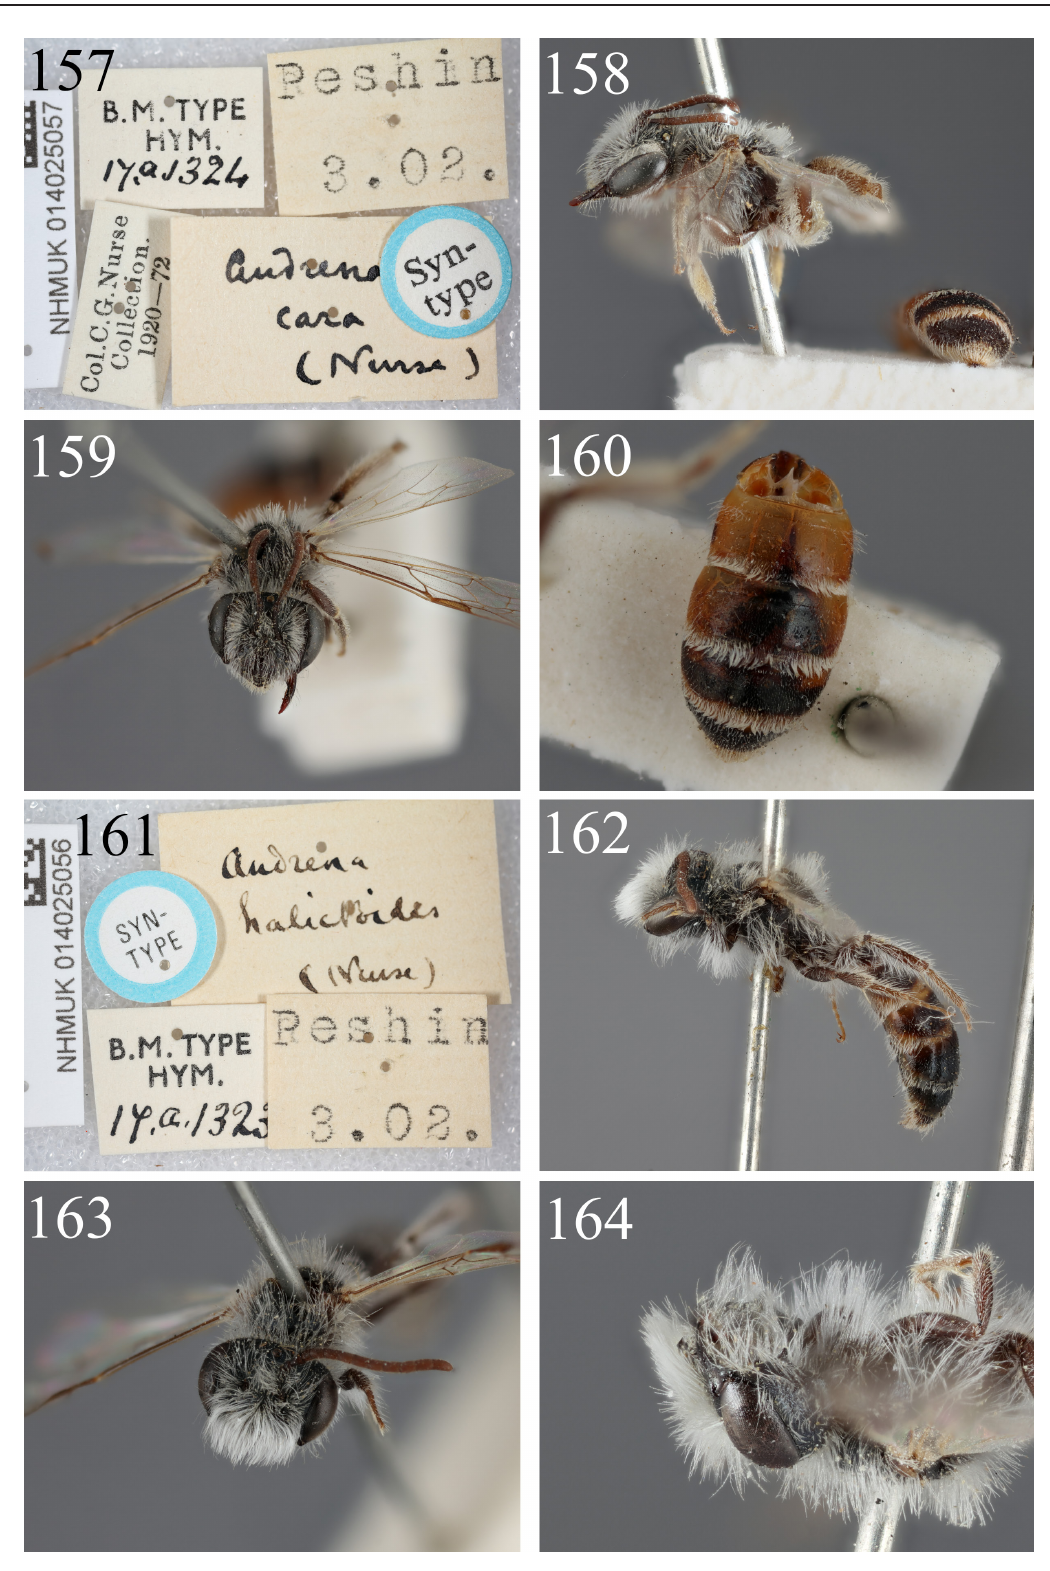
Figs 157–164. 157–160 . Andrena cara Nurse, 1904, ♀ syntype (NHMUK). 157 . Label